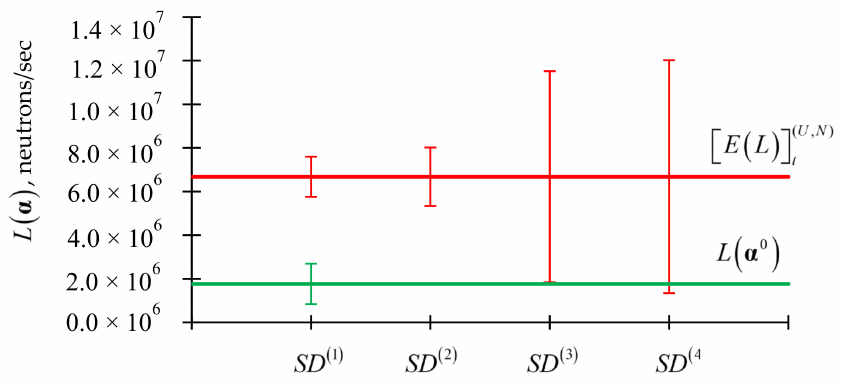
(cid:0) α 0 (cid:1) ± ( U , N ) ± SD ( 1 ) , SD ( 2 ) , SD ( 3 ) , SD ( 4 ) (in red), SD ( 1 ) (in green), [ E ( L )] t